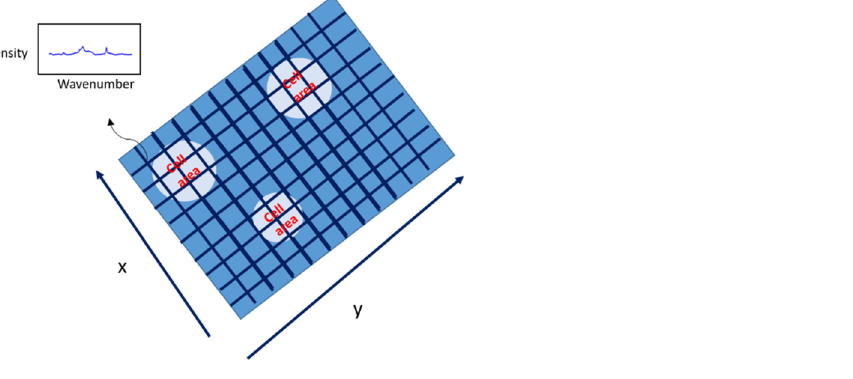
Figure 3. Each point at the intersection in the area provided a Raman spectrum. The Raman spectra and spatial data were used for intensity image simulation.